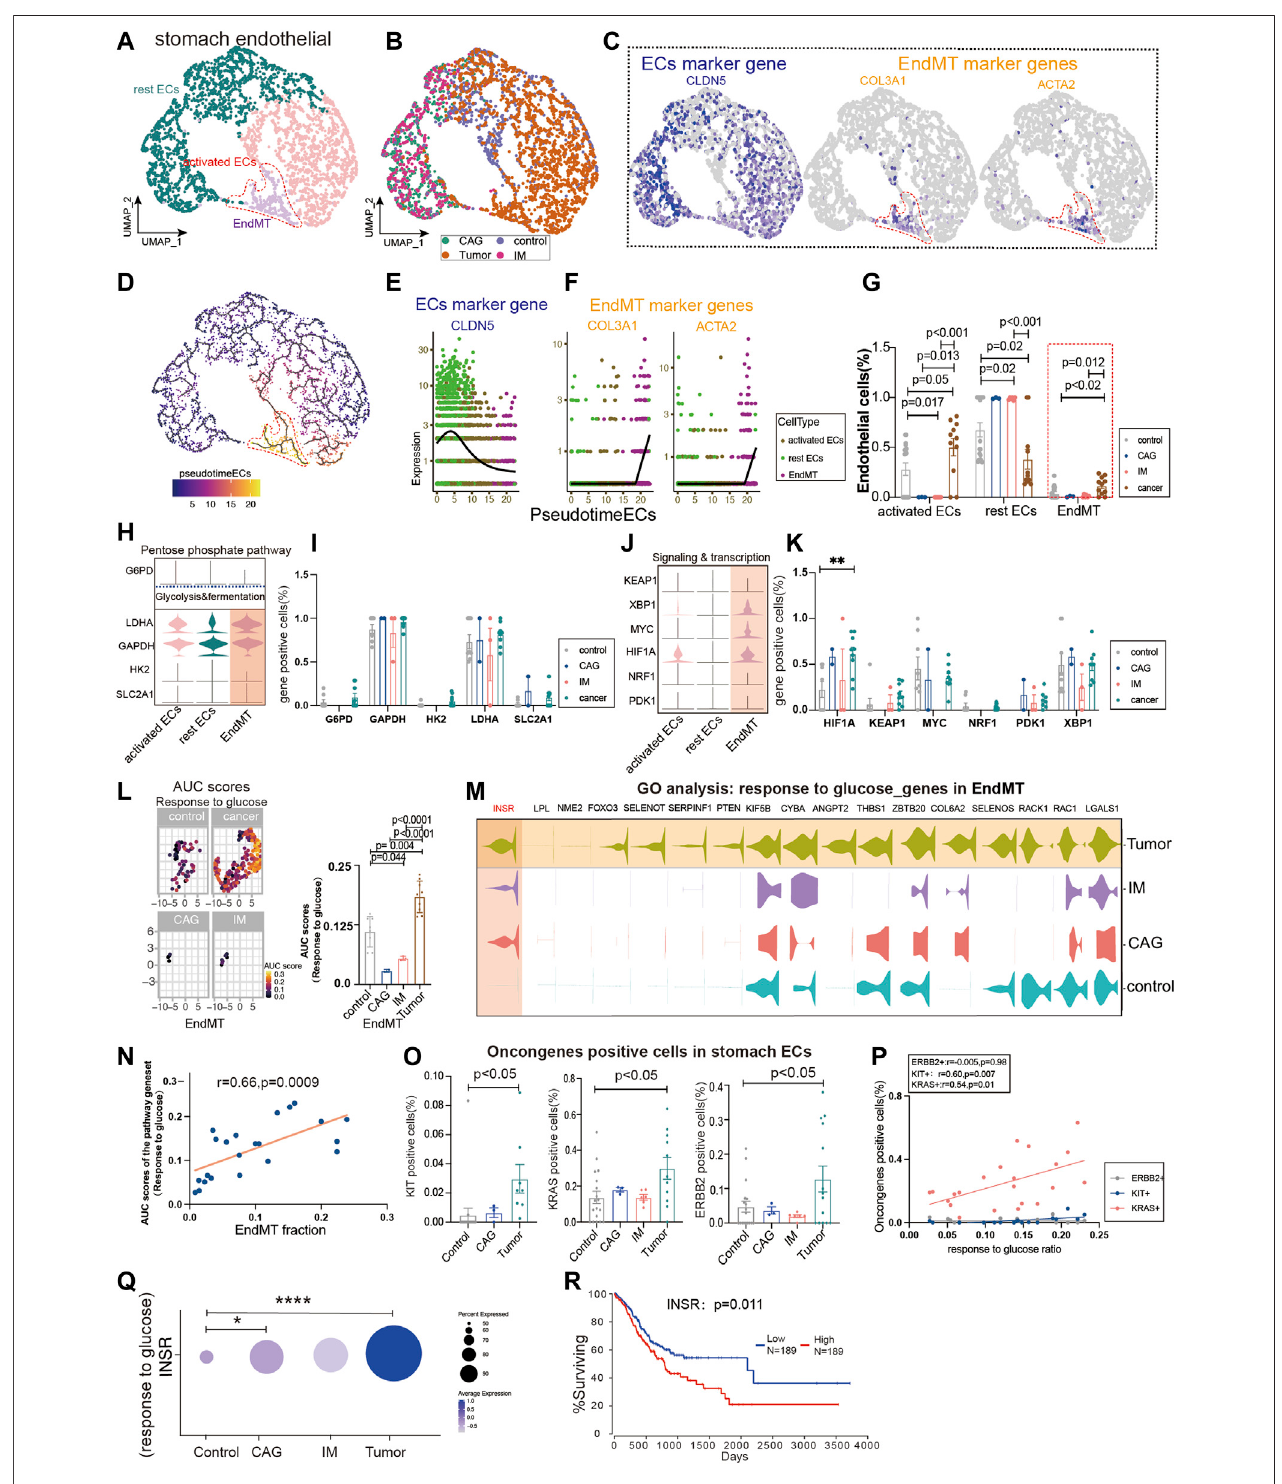
FIGURE3| Glucosemetabolismstatusofendothelial-to-mesenchymaltransition(EndMT)ingastricpremalignantlesionsandgastriccancer. (A,B) UMAPof3,558 stomachECsfrom18controlsamples,3CAG,6IM,and 11gastriccancer.Eachdot represents asinglecell,and cellsarelabeled bycelltype.UMAP demonstrates the cellular subpopulations of the stomach ECs, including EndMT, activated ECs, and rest ECs (see also Supplementary Table S2,S3 ). (C) UMAP plots showing EC- speci fi cmarkergenes( CLDN5 )andmesenchymalcell-speci fi cmarkergenes( COL3A1 and ACTA2 ). (D) Pseudo-temporalanalysisshowingtheevolutionary trend of ECs as “ rest EC-activated EC-EndMT. ” (E, F) Temporal variation of EC marker genes ( CLDN5 ), EndMT marker genes ( COL3A1 and ACTA2 ). (G) Cell proportions of